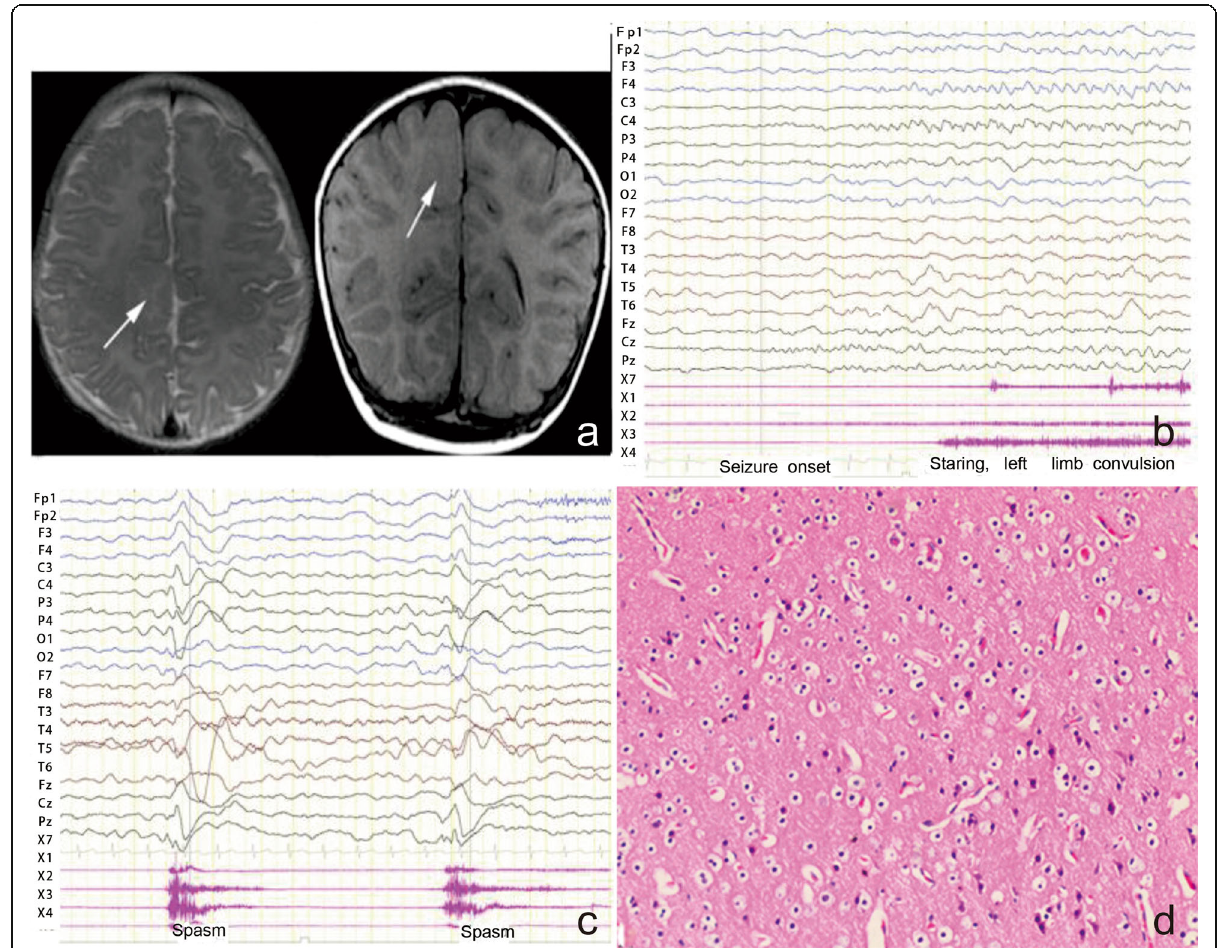
Fig. 3 MRI and video EEG for patient 2. a Cerebral MRI revealed an abnormal signal in the right frontal cortex (arrow), manifested as a structural abnormality of the cortex and an unclear boundary between gray matter and white matter. b , c Video EEG during a focal seizure starting at the right central and midline area ( b ) and during spasm attacks ( c ). d HE staining revealed glial cell proliferation and atrophy of some neurons (×